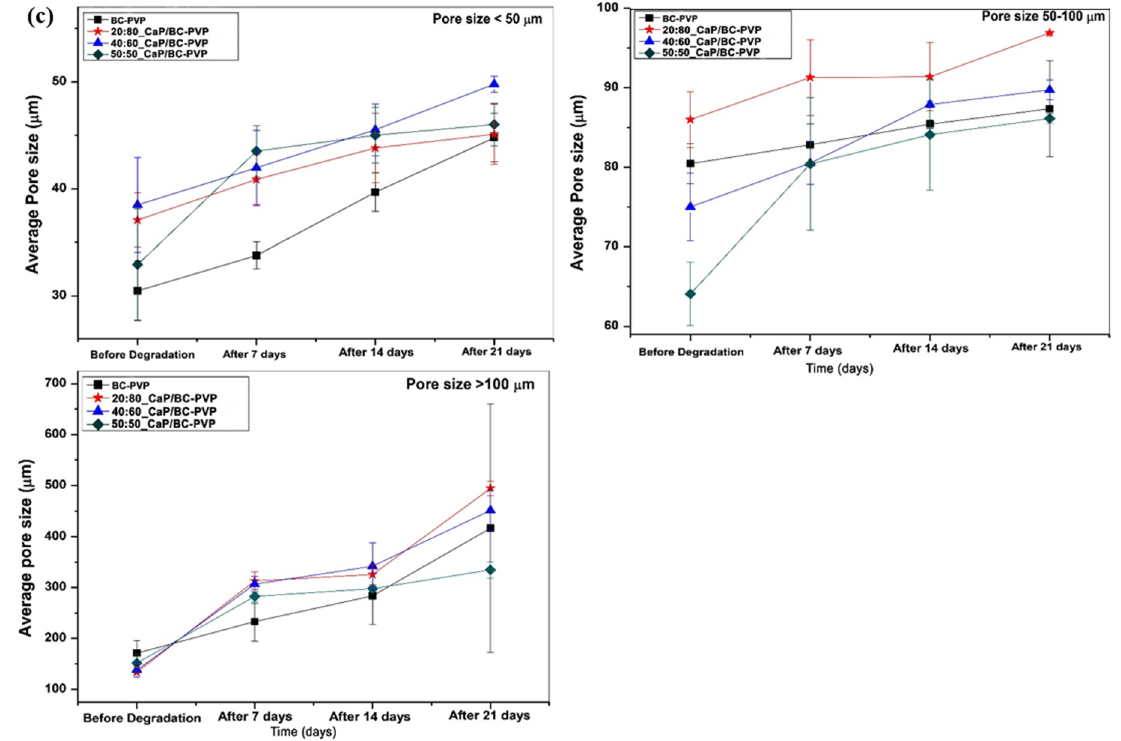
Figure 7. CaP / BC-PVP hydrogel sca ff olds ( a ) SEM-EDX of CaP / BC-PVP hydrogel sca ff olds indicates the Figure 7. CaP/BC-PVP hydrogel scaffolds ( a ) SEM-EDX of CaP/BC-PVP hydrogel scaffolds indicates presence of Ca and P in the sca ff olds; ( b ) SEM morphology of cross-sectional structure after hydrolytic the presence of Ca and P in the scaffolds; ( b ) SEM morphology of cross-sectional structure after degradation; ( c ) relationship average pore size (pores > 100 µ m, pores between 50–100 µ m, and pores < hydrolytic degradation; ( c ) relationship average pore size (pores > 100 µm, pores between 50–100 µm, 50 µ m) with hydrolytic degradation times. and pores < 50 µm) with hydrolytic degradation times.